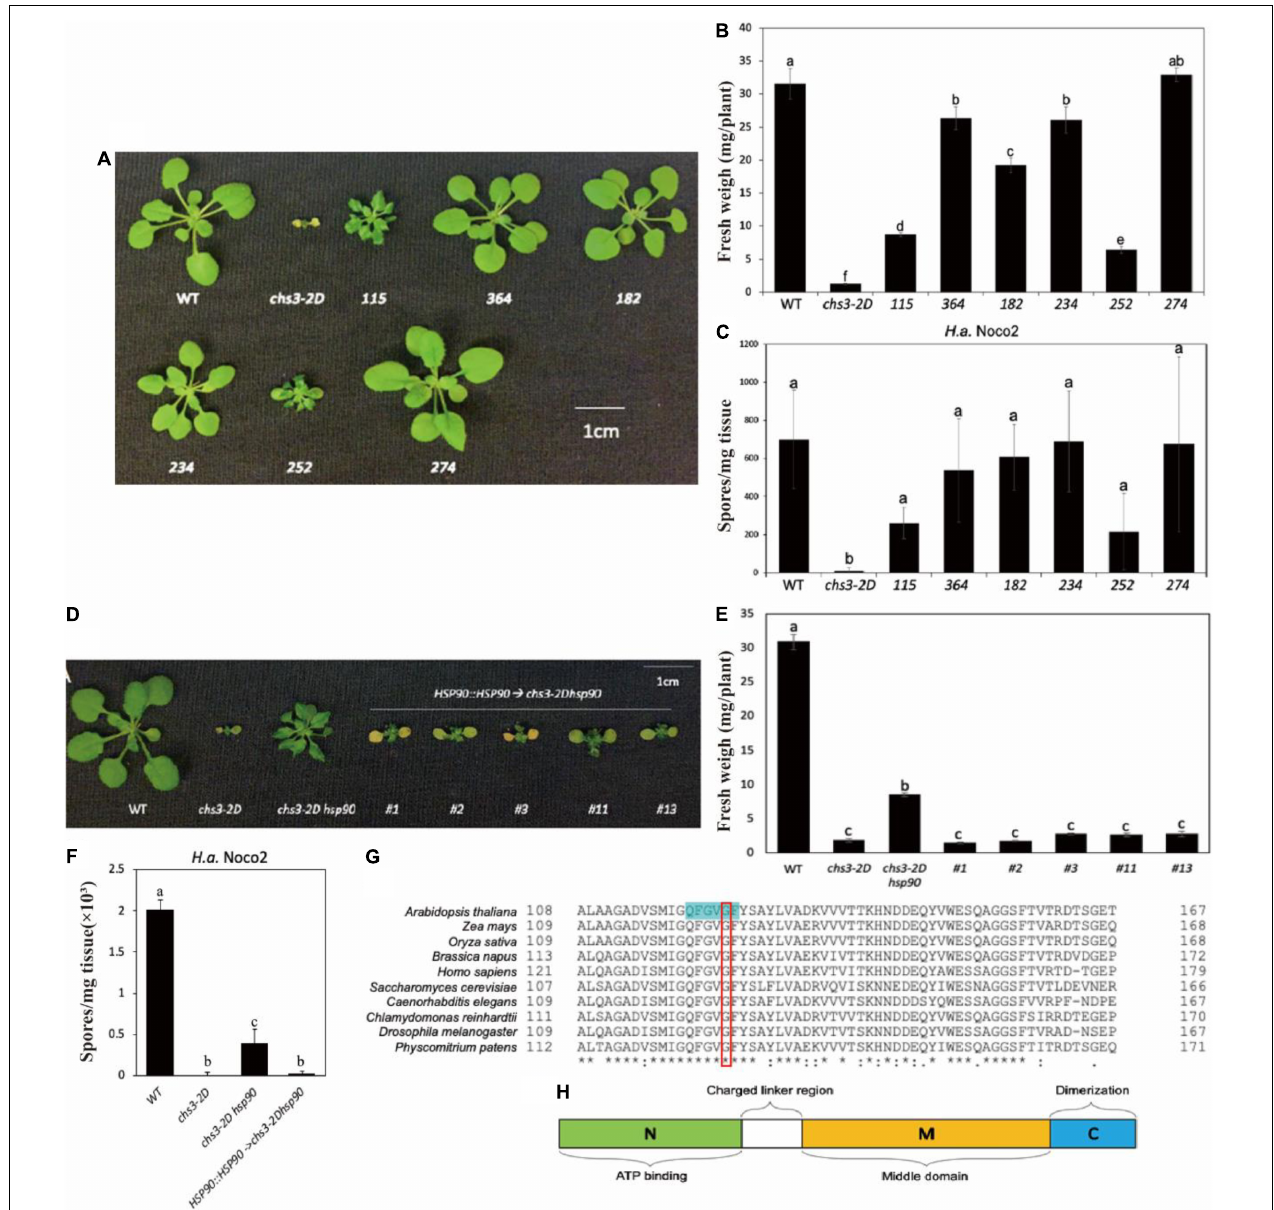
FIGURE 1 | Identification and characterization of chs3-2D suppressors. (A) Morphology of 3-week-old soil-grown plants of chs3-2D suppressors at 18 ◦ C. (B) Weights of 3-week-old soil-grown plants of chs3-2D suppressors at 18 ◦ C. (C) Quantification of H.a. Noco2 sporulation on the leaf surface of chs3-2D suppressors. (D) Morphology of 3-week-old soil-grown plants of the mutant chs3-2D hsp90.2 complementary transgenic lines at 18 ◦ C. (E) Weights of 3-week-old soil-grown plants of the mutant chs3-2D hsp90.2 complementary transgenic lines at 18 ◦ C. (F) Quantification of H.a. Noco2 conidia growth on the leaf surface of the mutant chs3-2D hsp90.2 complementary transgenic lines. (G) Amino acid alignments of selected HSP90 homologs from eukaryotic organisms. The amino acids highlighted in green are the nucleotide binding site. The mutated amino acid is labeled with a red box. For panel (G) , List of the organisms included: mouse-ear cress Arabidopsis thaliana HSP90.2, maize Zea mays (C3UZ63), rice Oryza sativa (Q0J4P2), rapeseed Brassica napus (A0A078GRJ1), human Homo sapiens (CAA33259.1), yeast Saccharomyces cerevisiae (AJS65103.1), nematode Caenorhabditis elegans (NP_506626.1), alga Chlamydomonas reinhardtii (XP_001695264.1), fruit fly Drosophila melanogaster (NP_001261362.1), and moss Physcomitrium patens (XP_024385281.1). Protein sequences were aligned using CLUSTAL. (H) Schematic diagram of the HSP90 domains. Hsp90 is comprised of three domains: an N-terminal ATP-binding domain (N, green) that may contain a peptide binding element; a middle domain (M, yellow) that interacts with client proteins and also contains a loop that catalyzes ATP hydrolysis; and a C-terminal dimerization domain (C, blue). A charged region exists between the N and M domains (linker region, white). Data information: For panels (C,F) , Two-week-old soil-grown seedlings were sprayed with a spore suspension of H.a. Noco2 at a concentration of 100,000 spores/ml of water. The plants were then covered and incubated for seven days in a high humidity growth chamber. Spores were counted in water suspension using a hemocytometer (bars represent means of n replicates ± SD, n = 3 with 4 plants each). One-way ANOVA followed by Tukey’s post hoc test were performed for panels (A–F) . Statistical significance is indicated by different letters ( P < 0.05). Error bars represent mean SD ( n = 5).